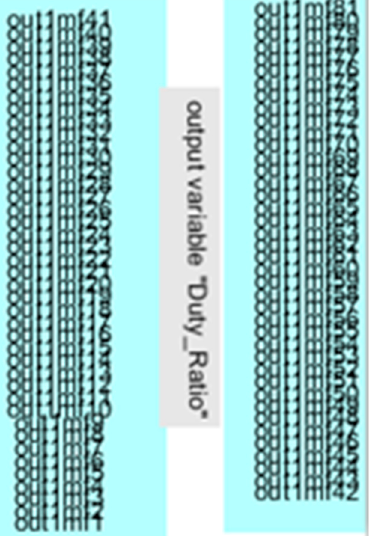
Figure 32. Output variable ‘Duty ratio’ membership functions.